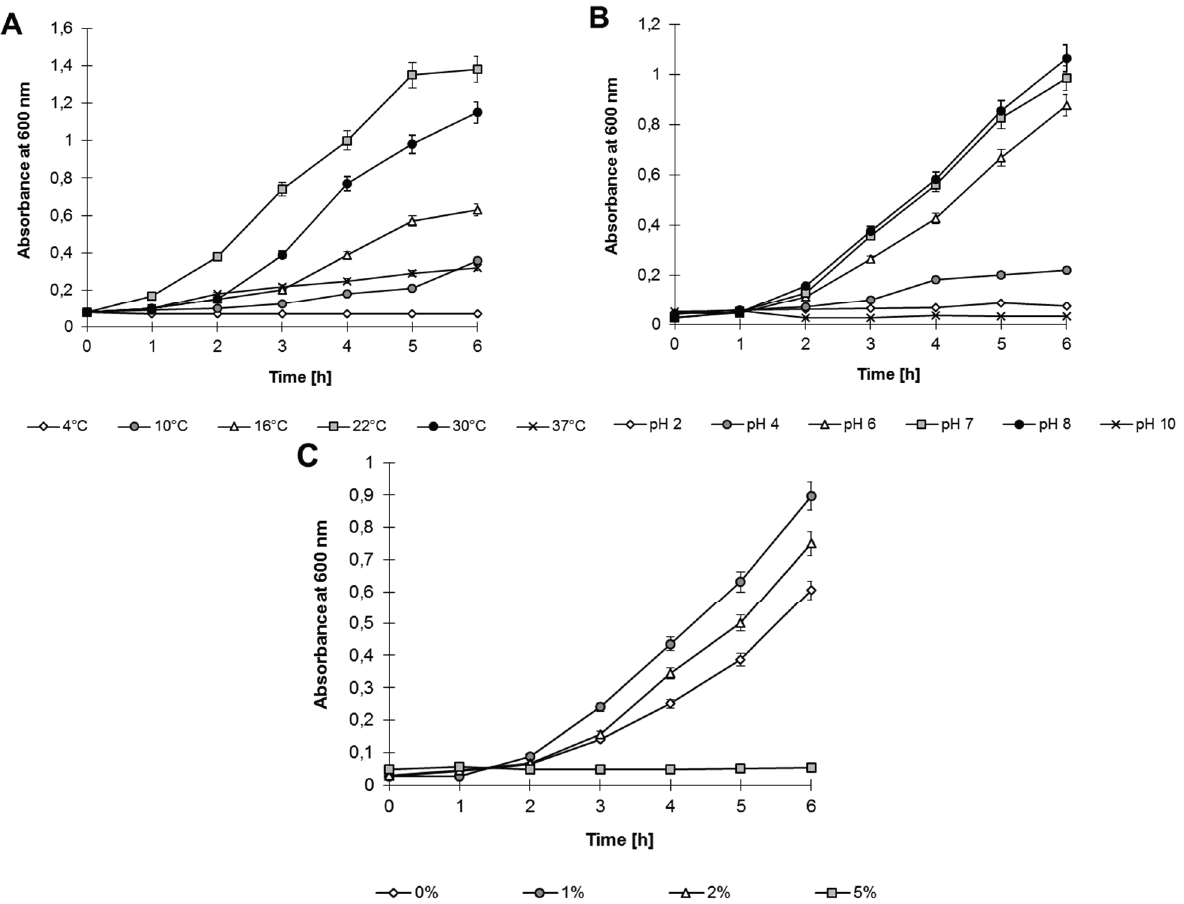
Figure 3. Growth of Shewanella sp. O23S under various stress conditions: ( A ) Temperature; ( B ) pH; and ( C )